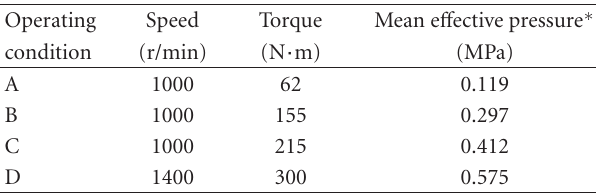
Table 4: Test operating